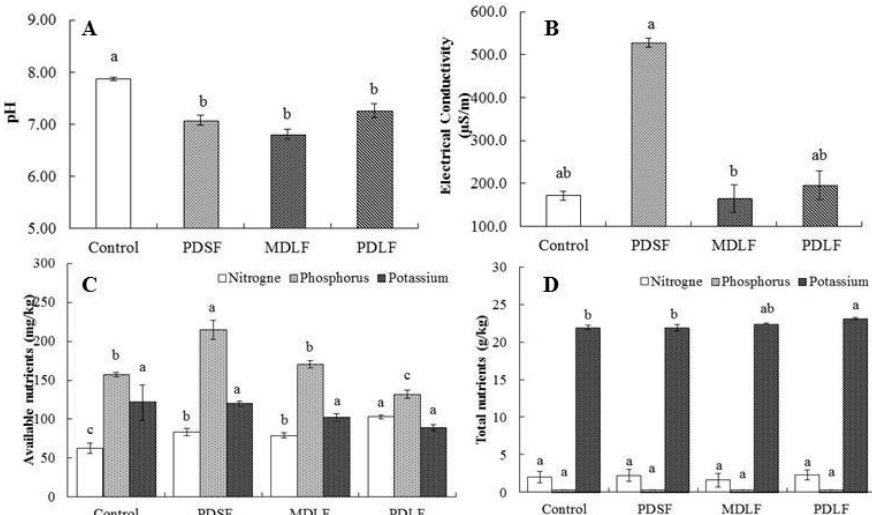
Figure 2. The effect of PDSF (plant-derived Solid), MDLF (mineral-derived liquid), and PDLF (plant-derived liquid) fulvic acids (FA) on ( A ) soil pH, ( B ) electrical conductivity, ( C ) soil available nutrients, and ( D ) soil total nutrients of dry soil from pot experiment. Error bars represent standard errors of the means ( n = 4). The least significant differences (LSD 0.05 ) are at 5% level of significance, different letter on top of each bar showing a significant difference between treatments.